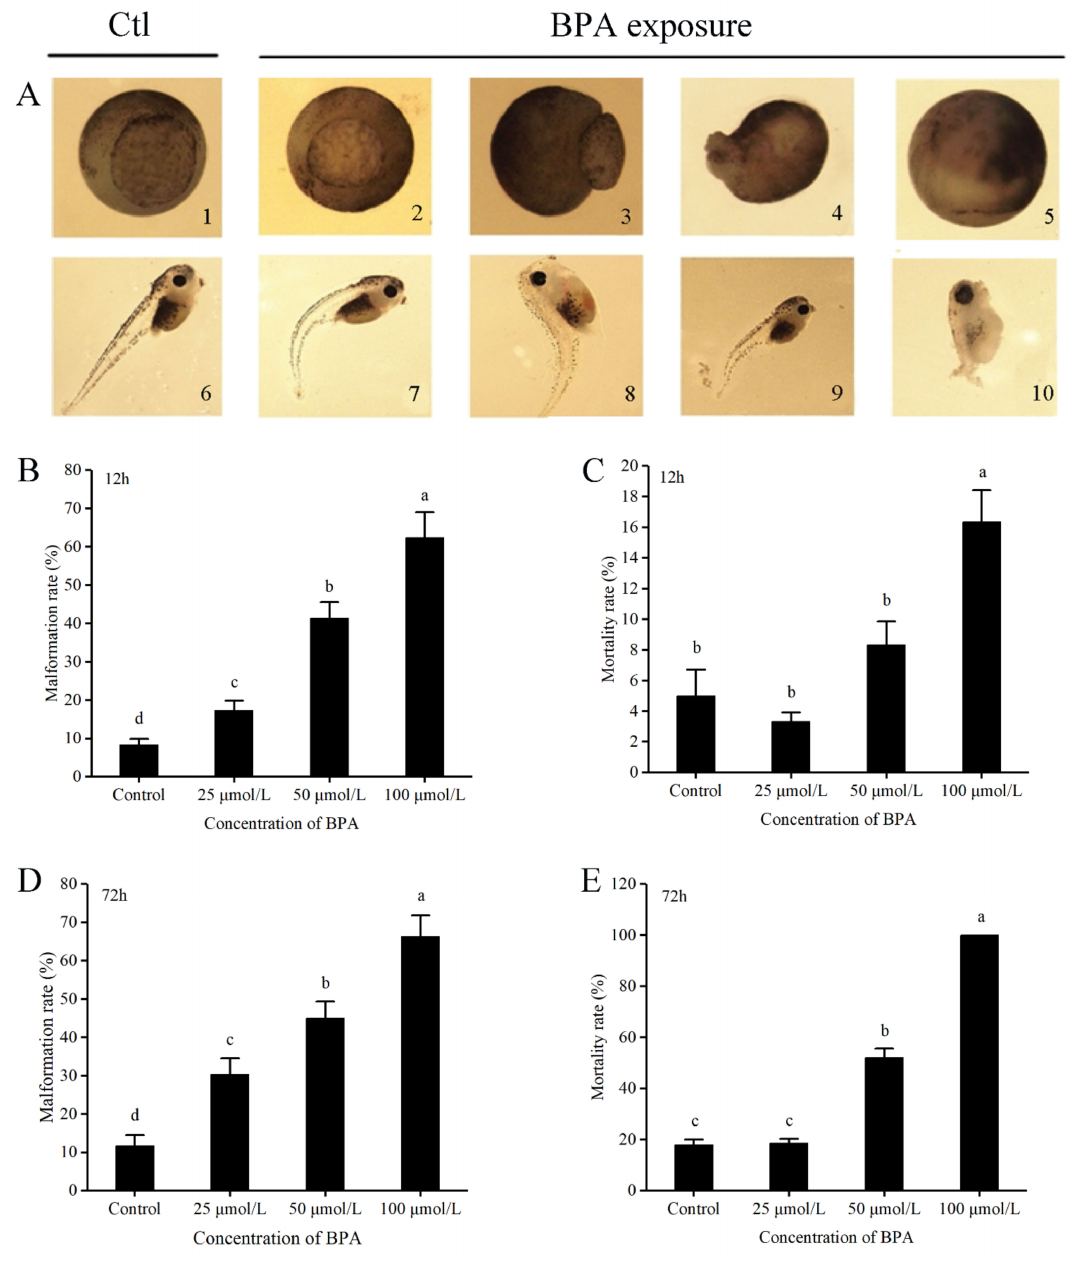
Figure 2. BPA induces malformation during X. tropicalis embryonic development. The embryos were exposed to different concentrations of BPA for 12 h; when the BPA was removed, the embryos were at stage 10.5 (early gastrula) (( A ) 1–5), and the malformation analysis ended at the later tadpole stage 46 (( A ) 6–10). The malformation rates were statistically analyzed at 12 h (stage 10.5) ( B ) and 72 h (stage 46) ( D ). The mortality rates were statistically analyzed at 12 h (stage 10.5) ( C ) and 72 h (stage 46) ( E ). Different letters above the bars indicate significant differences among groups (a > b > c > d, p < 0.05). n =